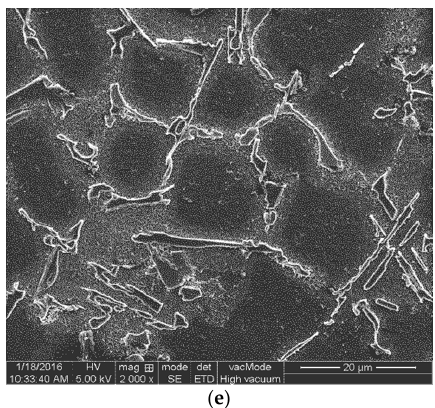
Figure 9. Eutectic Si in Al-8Si alloy with different amount of Al-5Ti-0.62C-0.2Ce master alloy ( a ) unmodified; ( b ) 0.8%; ( c ) 1.0%; ( d ) 1.5%; and ( e ) 2.0%.